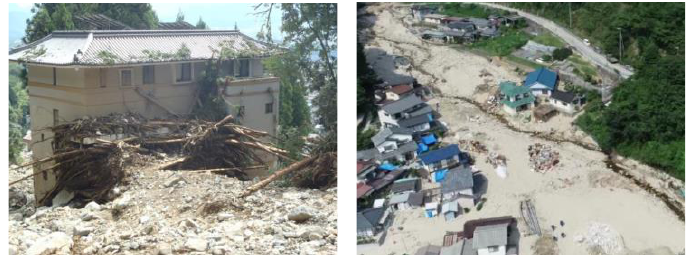
Figure 2. Damage caused by heavy rain in Hiroshima ( left : H26, right : H30) [2].